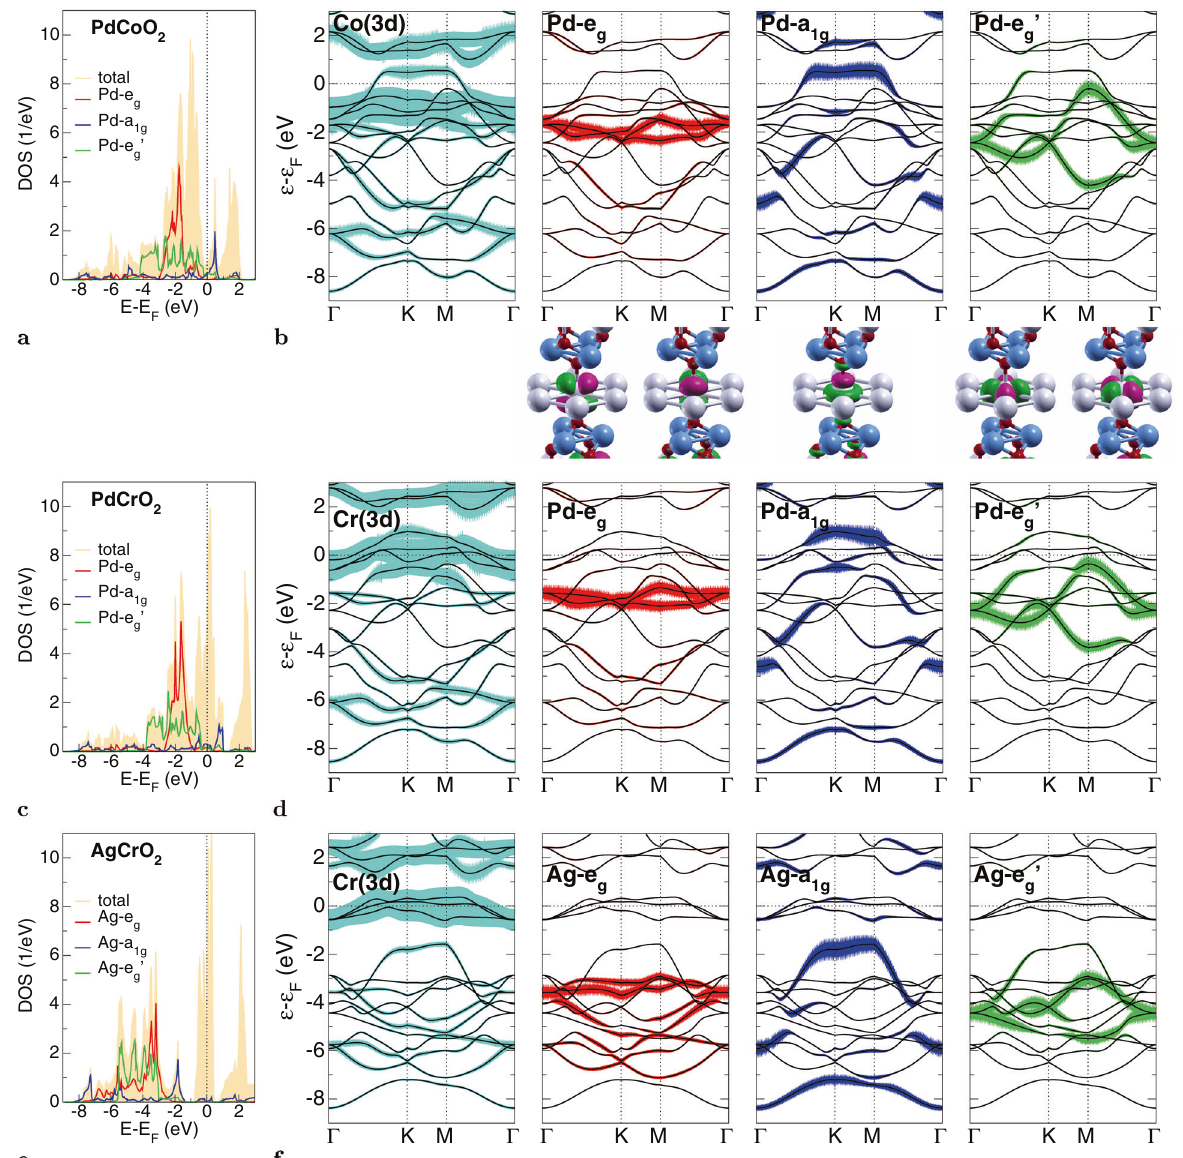
Fig. 3 DFT electronic structure of PdCoO 2 , PdCrO 2 and AgCrO 2 . a Total and orbital-resolved A -site(4 d ) density of states. ( b ) Band structure along high symmetry lines in the k z = 0 plane, with fatbands marking the B -site(3 d ) and the orbital-resolved A -site(4 d ) character. Additonally, the corresponding real-space Pd(4 d ) projected local orbitals are provided for the case of PdCoO 2 : Pd (grey), Cr (lightblue) and O (red). c , d Same as ( a , b ) but for PdCrO 2 . e , f Same as ( a , b ) but for AgCrO 2 hints for localized Cr 3 + S = 3/2 spins 12,71,73 . The QP peak at low energy is of dominant Pd(4 d ) character, therefore con fi rming the previously announced mechanism of a correlation-induced shift of a DFT-original deeper lying Pd-dominated band towards ε . The F projected AgCrO 2 spectrum shows again the Mott-insulating Cr (3 d ) part along with the band-insulating Ag(4 d ) part. The plots of A ν ( ω ) render obvious that for PdCoO 2 the low-energy QP is for the most part constituted from a single Pd-dominated Bloch dispersion, which we call LE-Pd. The same holds for the PdCrO 2 case. Yet importantly, both QP peaks display the hybridizing contribution of Co/Cr-dominated functions, and the LE-Pd function moreover exhibts signi fi cant energy dependence. Both features point to the relevance of the subtle impact of electronic correlation onto the low-energy regime. Or in other words, the ’ single-band ’ dispersion crossing ε , though not dominated by the F strongly-interacting B -site 3 d orbitals, still carries subtle effects of